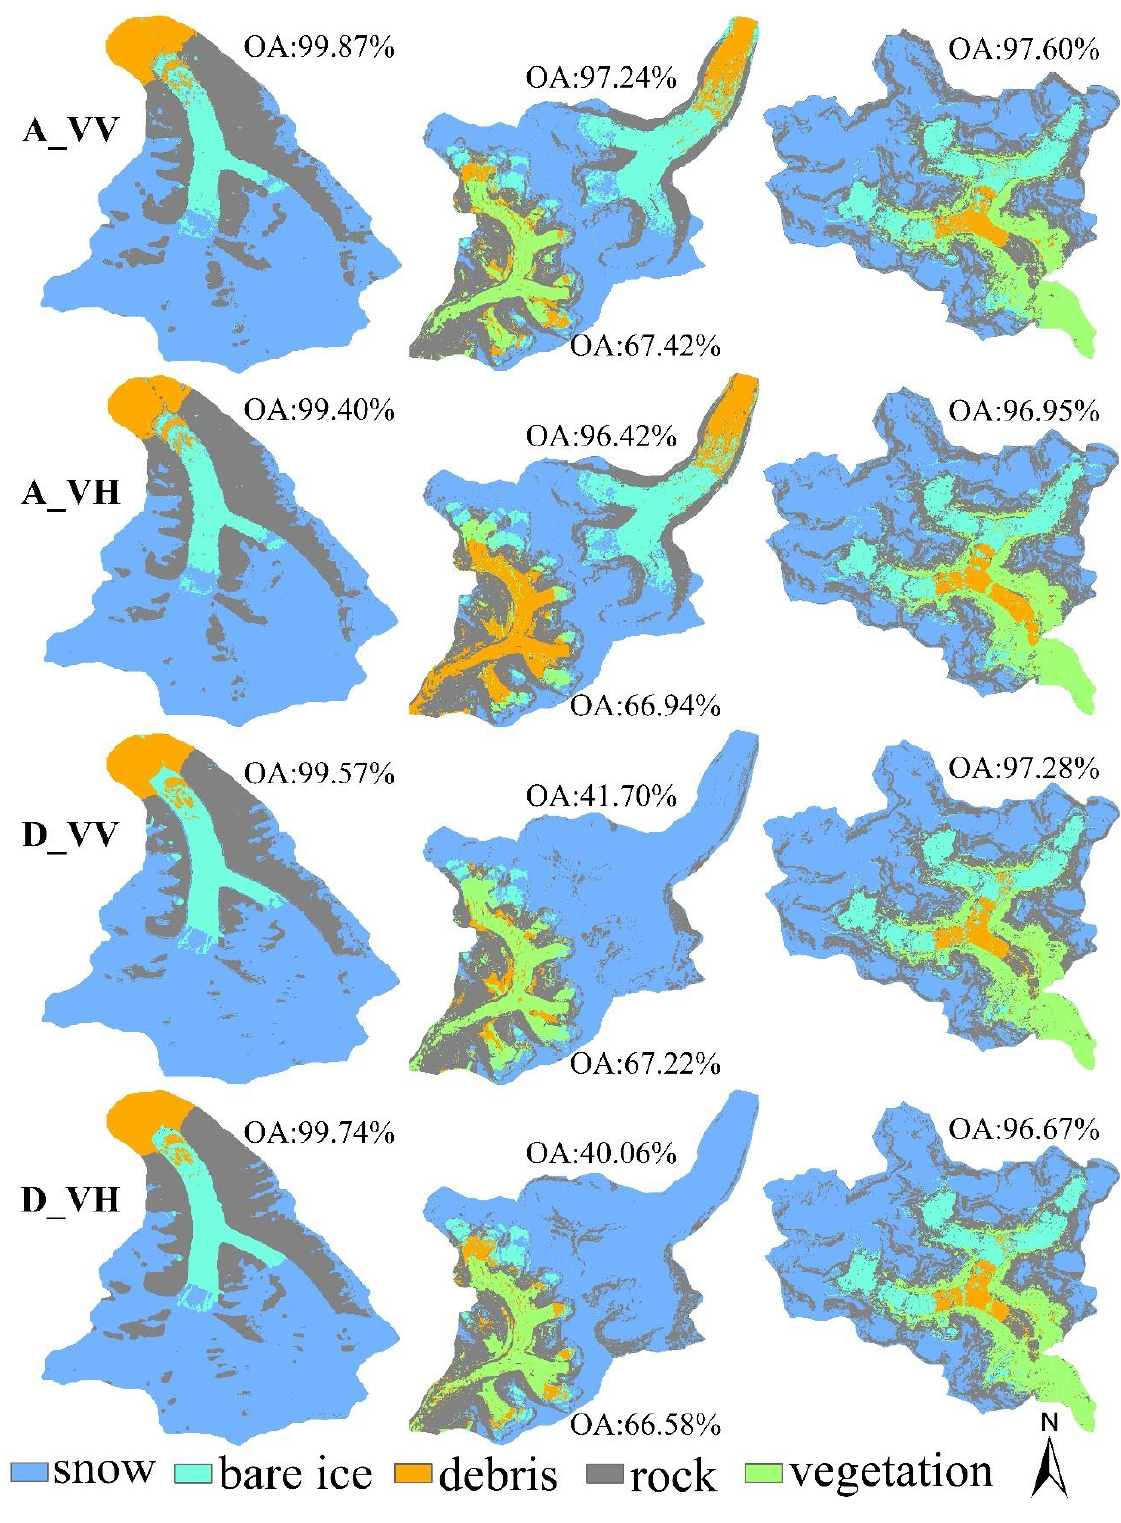
Figure 11. Glacier classification results of four glaciers from the four ICC data suites.